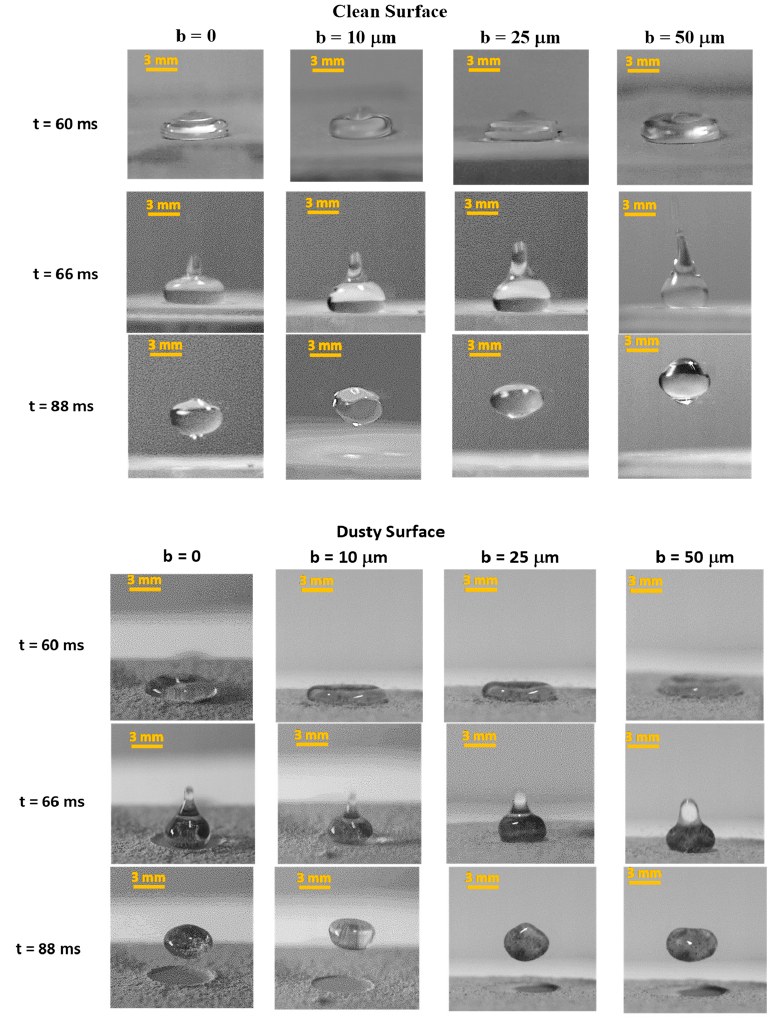
Figure 14. High ‐ speed camera images of impacting droplets on clean and dusty surfaces for various micro ‐ post spacings and impact and rebounding durations. The micro ‐ post array spacing b = 0 represents flat hydrophobized surface. Table 2. Variation of ratio of dust removed area with We number for 10 μ L droplet.